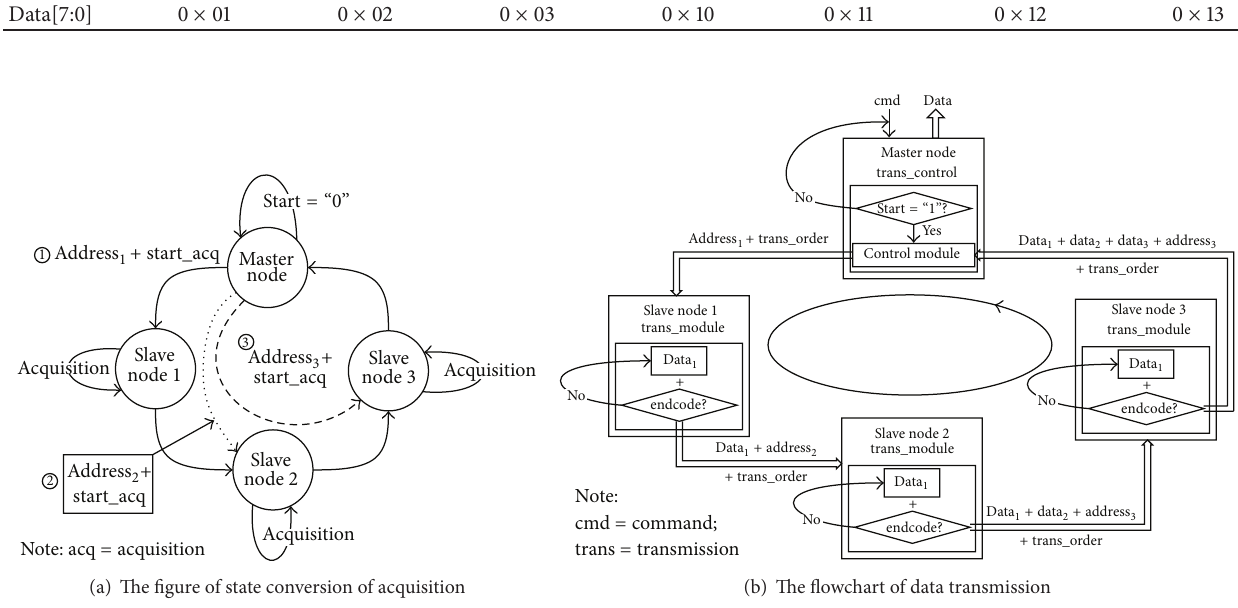
(b) The flowchart of data transmission Figure 4: The flowchart of data acquisition and transmission in the STM when 𝑛 = 3 .